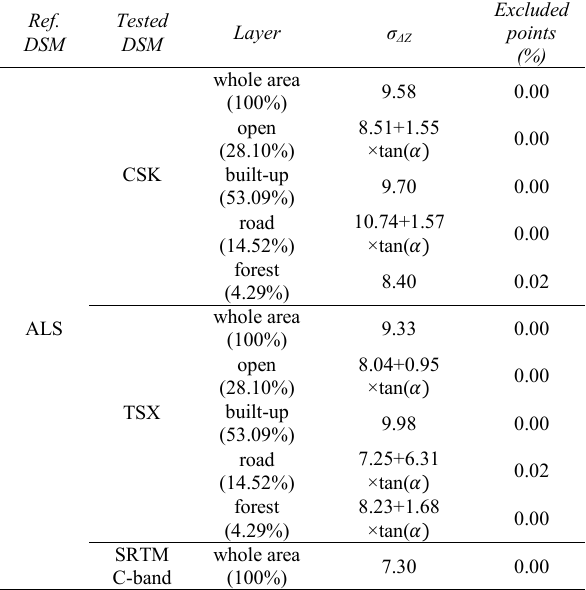
Table 3. The AVAs of CSK, TSX, and SRTM C-band DSMs against ALS DSM Ref. DSM